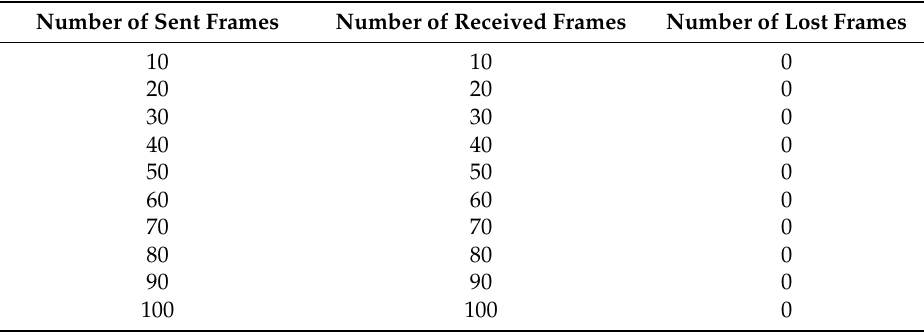
Table 2. Network frame statistics in Simulation 1.